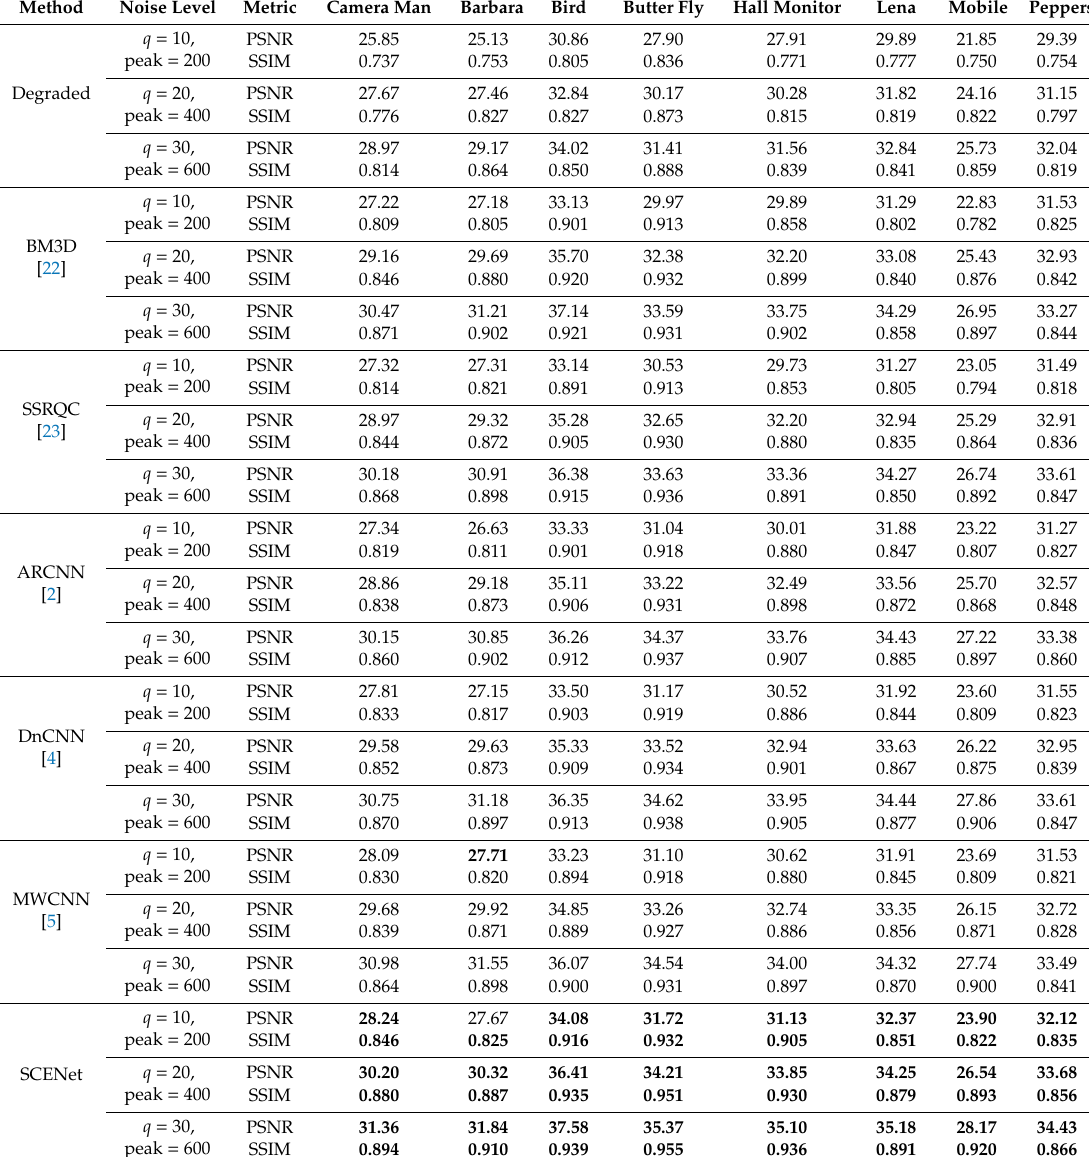
Table 1. Comparison of the objective quality on classical images in terms of PSNR (dB) and SSIM. Bold values indicate the best scores.